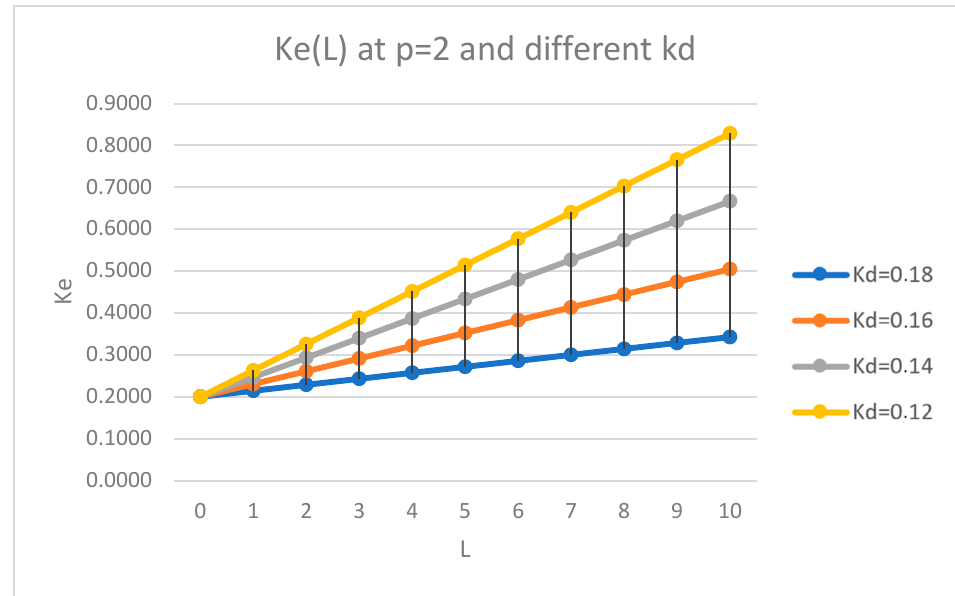
Figure 18. Dependence of the equity cost, k e , on leverage level L at different debt cost k d (12%; 14%; 16%; 18%) and fixed frequency of payments of tax on profit p = 2.